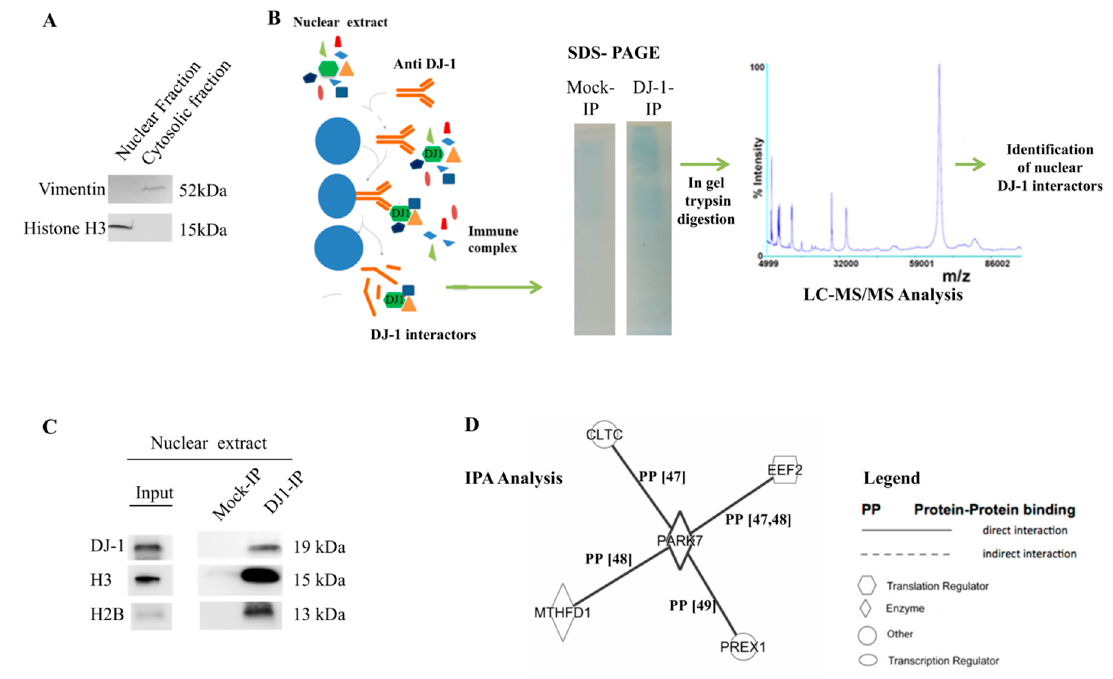
Figure 5. Mass spectrometry identification of DJ-1 nuclear interactors. ( A ) The quality of nuclear extracts was assessed by Western blot using vimentin as marker of cytosolic fraction and Histone H3 as marker of nuclear fraction; ( B ) DJ-1 nuclear interactors were obtained by pull-down nuclear proteins extracted from breast cancer cell (MCF7), using anti-DJ-1 antibody. In parallel, a Mock IP using only protein A / G resin was done to identify unspecific interactors. Immunocomplexes were resolved by SDS-PAGE (Any kD Mini-PROTEAN TGX Precast Protein Gels). Gel bands from mock-IP and DJ-1-IP were manually excised, trypsin digested, and analyzed by LC-MS / MS. Proteins identified in mock-IP were classified as unspecific interactors and eliminated from the list of specific DJ-1 nuclear interactors. The complete list of DJ-1 interactors was provided as Supplementary File S5; ( C ) The interaction of DJ-1 with Histones H2B and H3 was also confirmed by Western blot analysis. Mock-IP was loaded as negative control; ( D ) DJ-1 interactors were analyzed using the ingenuity pathways analysis (IPA) tool. Identified networks were provided as Supplementary File S5. IPA analysis allows us to exploit that some of the identified proteins have just been reported as DJ-1 interactors. The network in panel E confirms the direct interaction of DJ-1 with Clathrin heavy chain 1(CLH1), methylenetetrahydrofolate dehydrogenase (MTHFD1), Elongation factor 2 (EF2), and Phosphatidylinositol 3,4,5-trisphosphate-dependent Rac exchanger 1 protein (PREX1). PP on the line connecting proteins indicates protein-protein binding. Peculiar proteins interactions are provided as Supplementary File